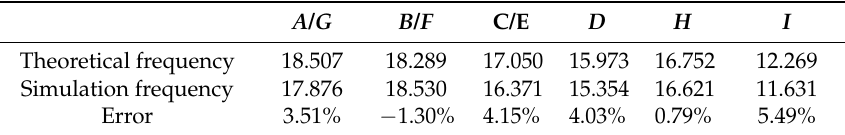
Table 3. Comparison of the finite element simulation and theoretical results. A /